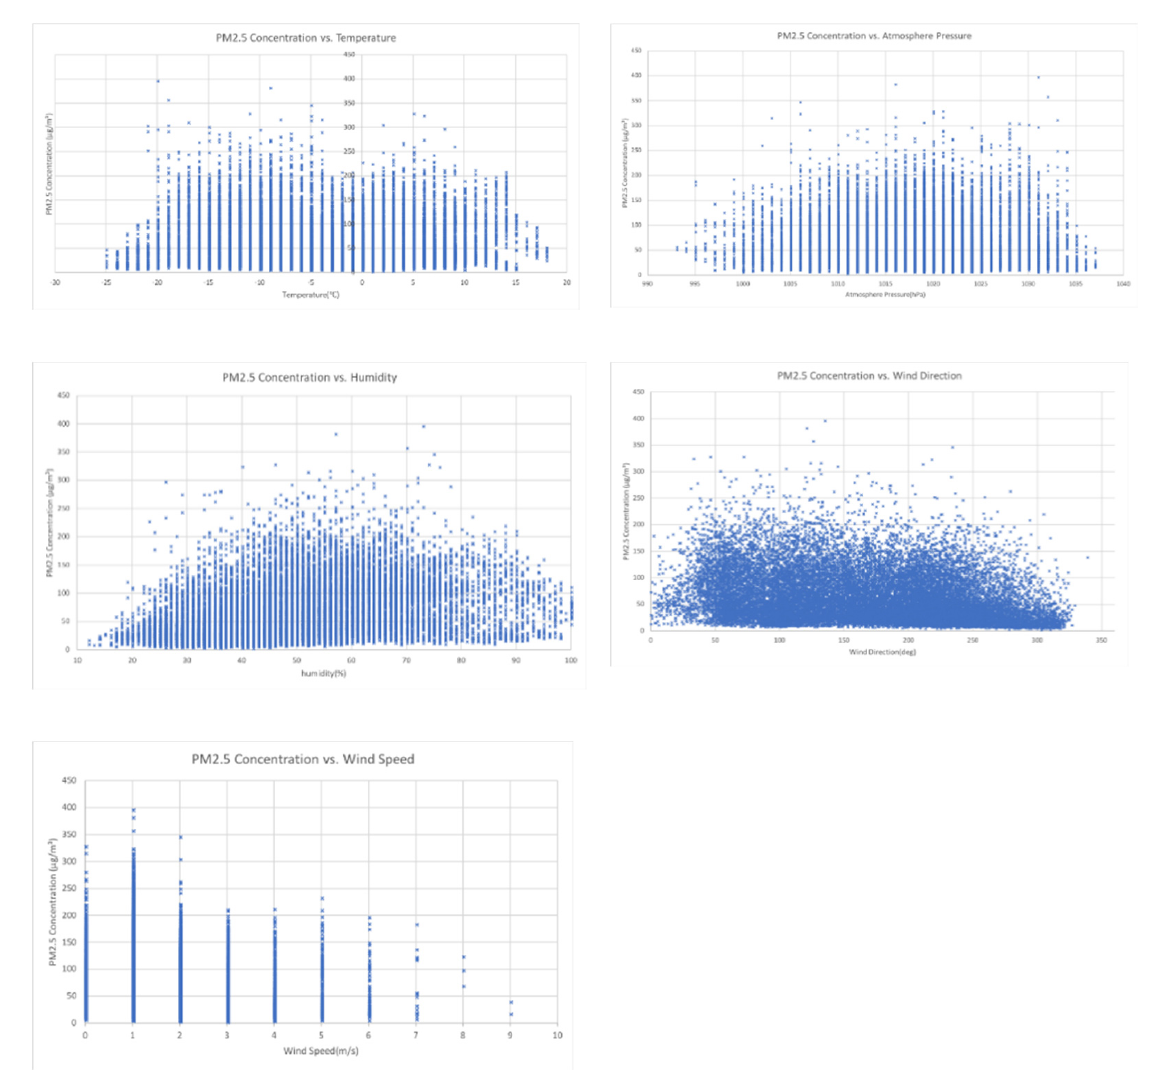
Figure 2. The scatter gram of PM 2.5 vs. other meteorological indices.